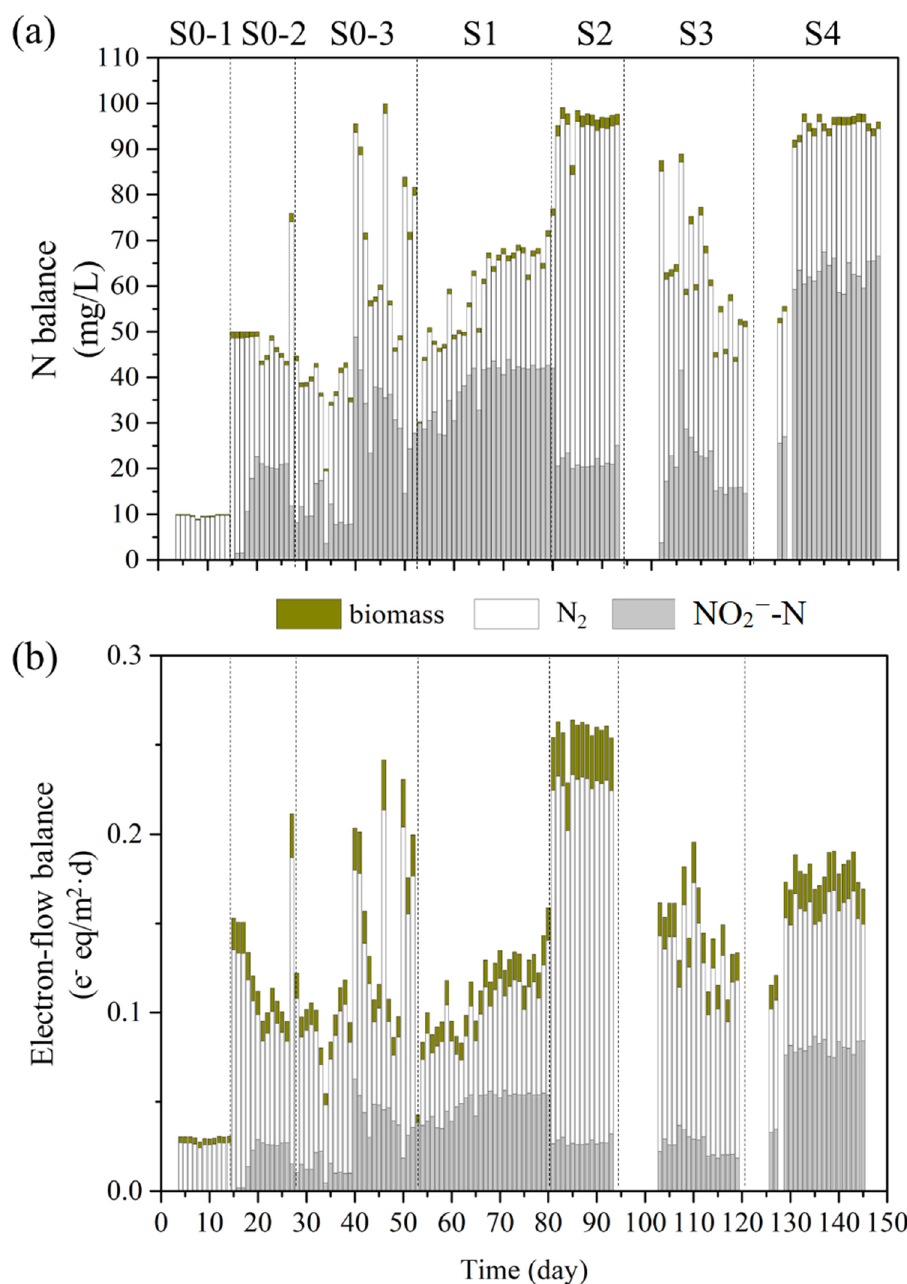
Figure 3. The N balance ( a ) and electron-flow balance ( b ), along with biomass synthesis ( a , b ) in full and partial